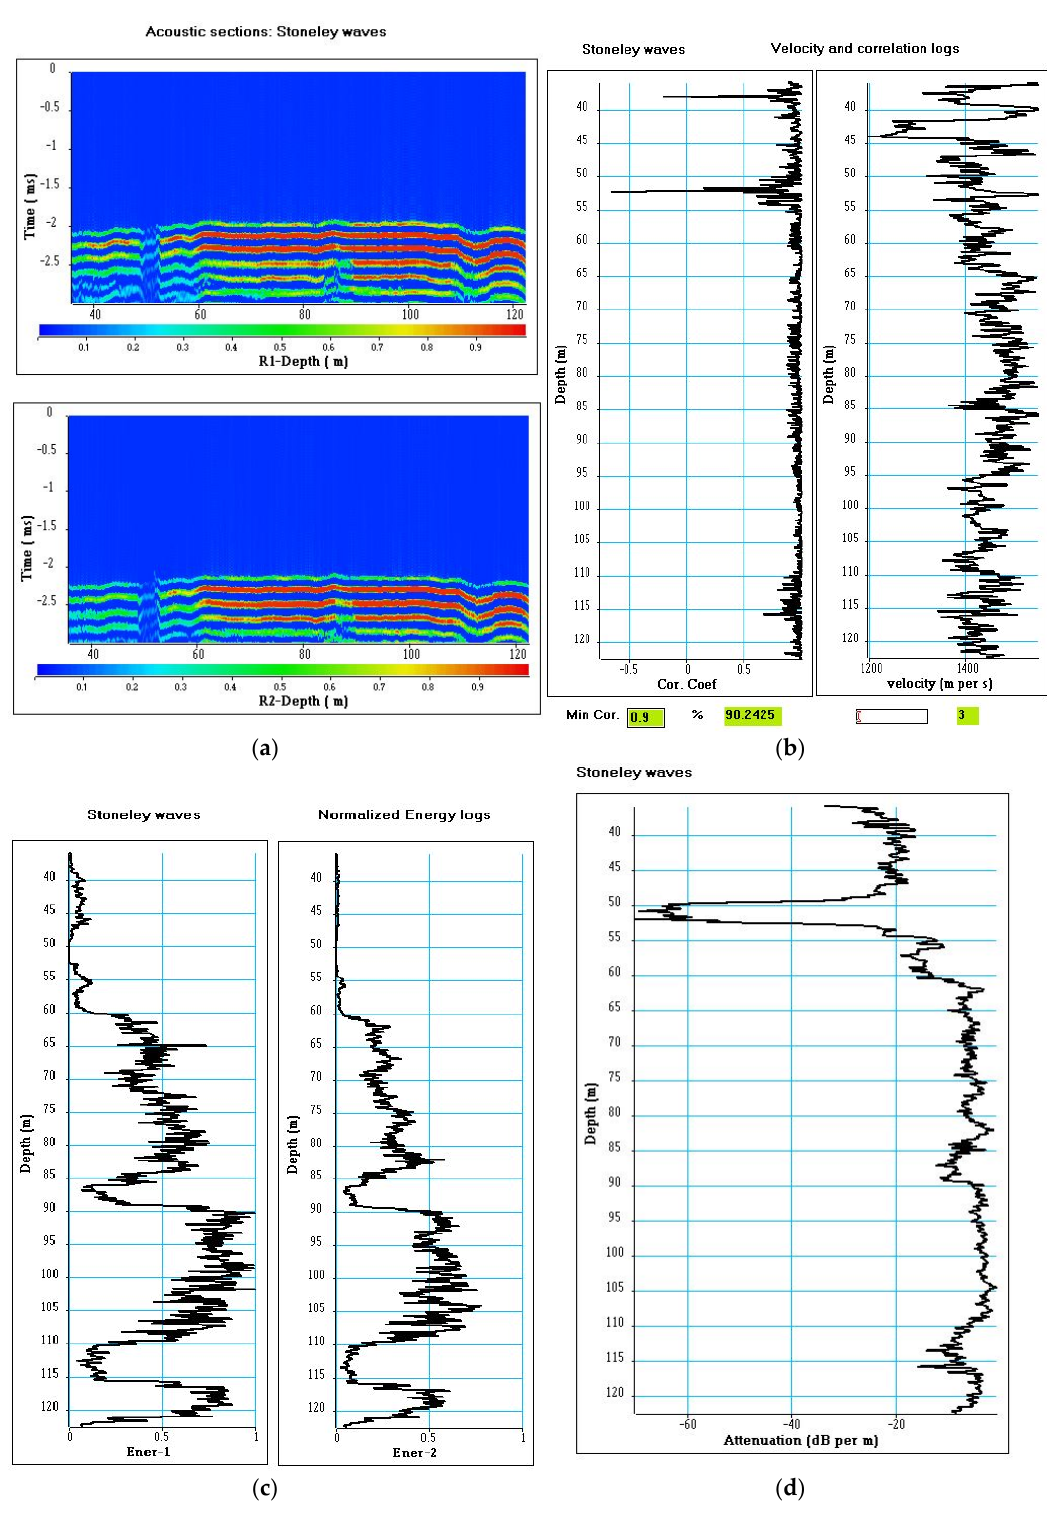
Figure 11. Stoneley waves. ( a ) Acoustic sections after mute. Vertical axis: recording time in ms, horizontal axis: depth of receiver R1 or R2, color scale: normalized amplitude, ( b ) velocity log and its associated correlation coefficient log, ( c ) normalized energy logs, ( d ) attenuation log.